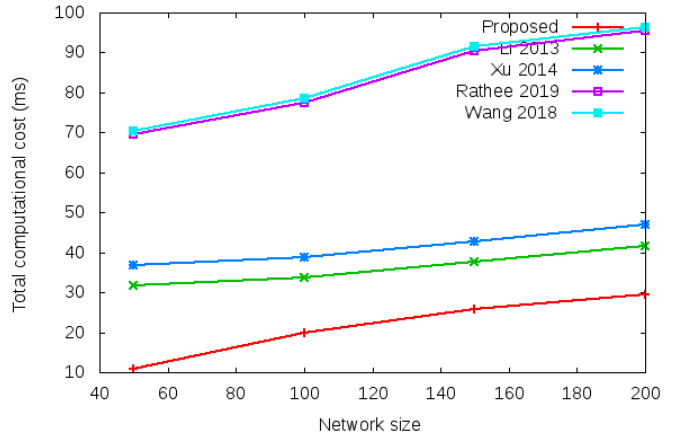
Figure 6. Total computational cost of proposed protocol vs. existing protocols with different network size of 50, 100, 150, and 200 nodes during handover process.